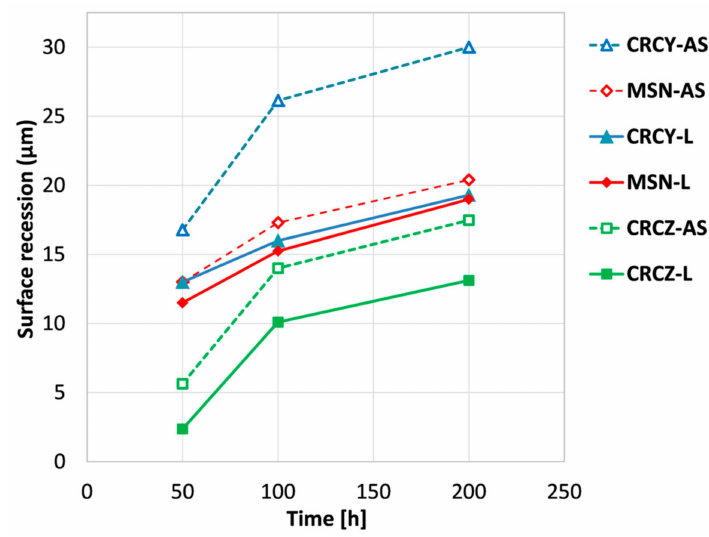
Figure 12. Coating recession caused by hot corrosion exposure of increasing duration for the as-sprayed (AS, dashed line) and laser-treated (L, solid line)